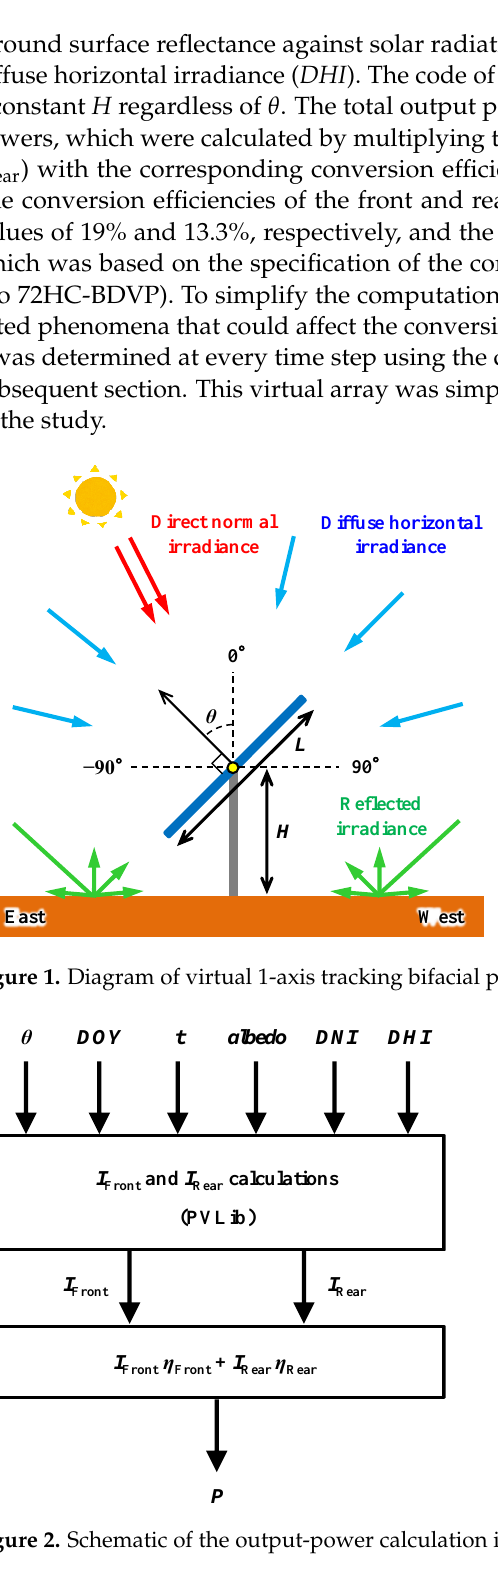
Figure 2. Schematic of the output-power calculation in virtual 1-axis tracking BPV array.